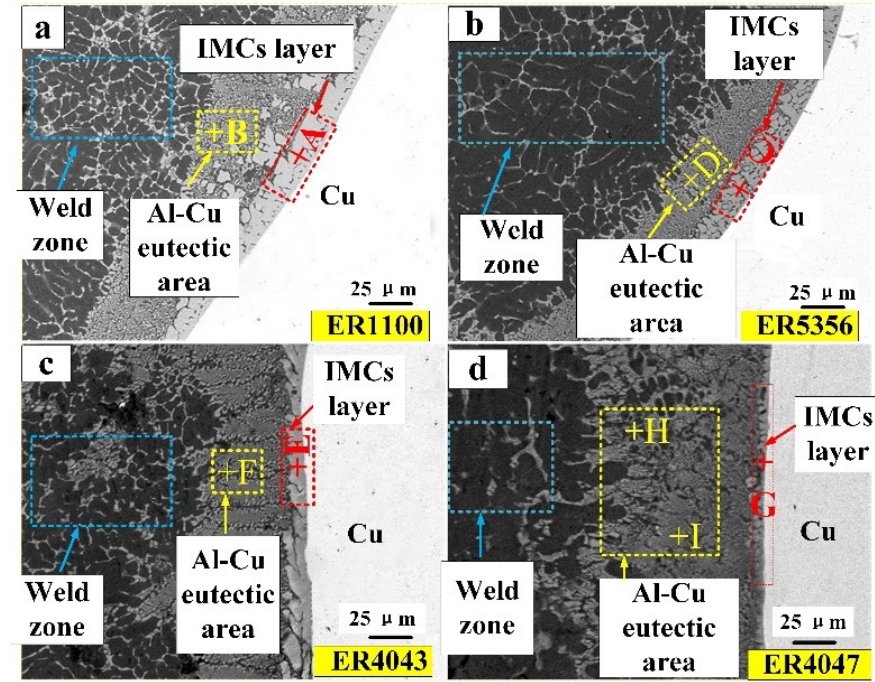
Figure 7. Microstructure of joints at copper side brazing interface zone ( I main = 60 A): ( a ) ER1100 welding joint; ( b ) ER5356 welding joint; ( c ) ER4043 welding joint; ( d ) ER4047 welding joint.